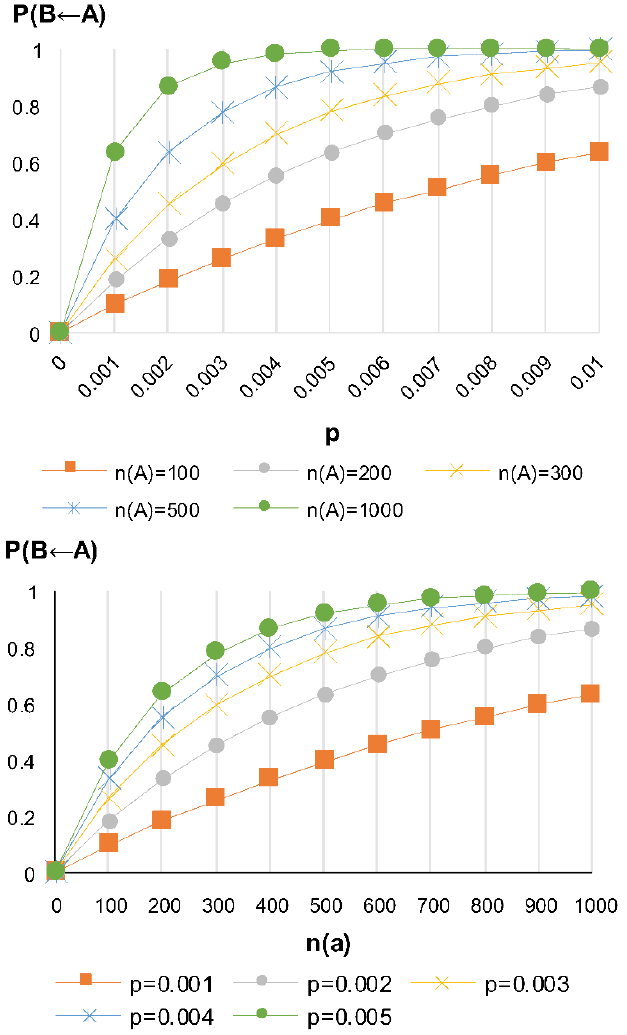
Figure 1. Risk of infection by a single virus in subject B according to the number of viral populations.